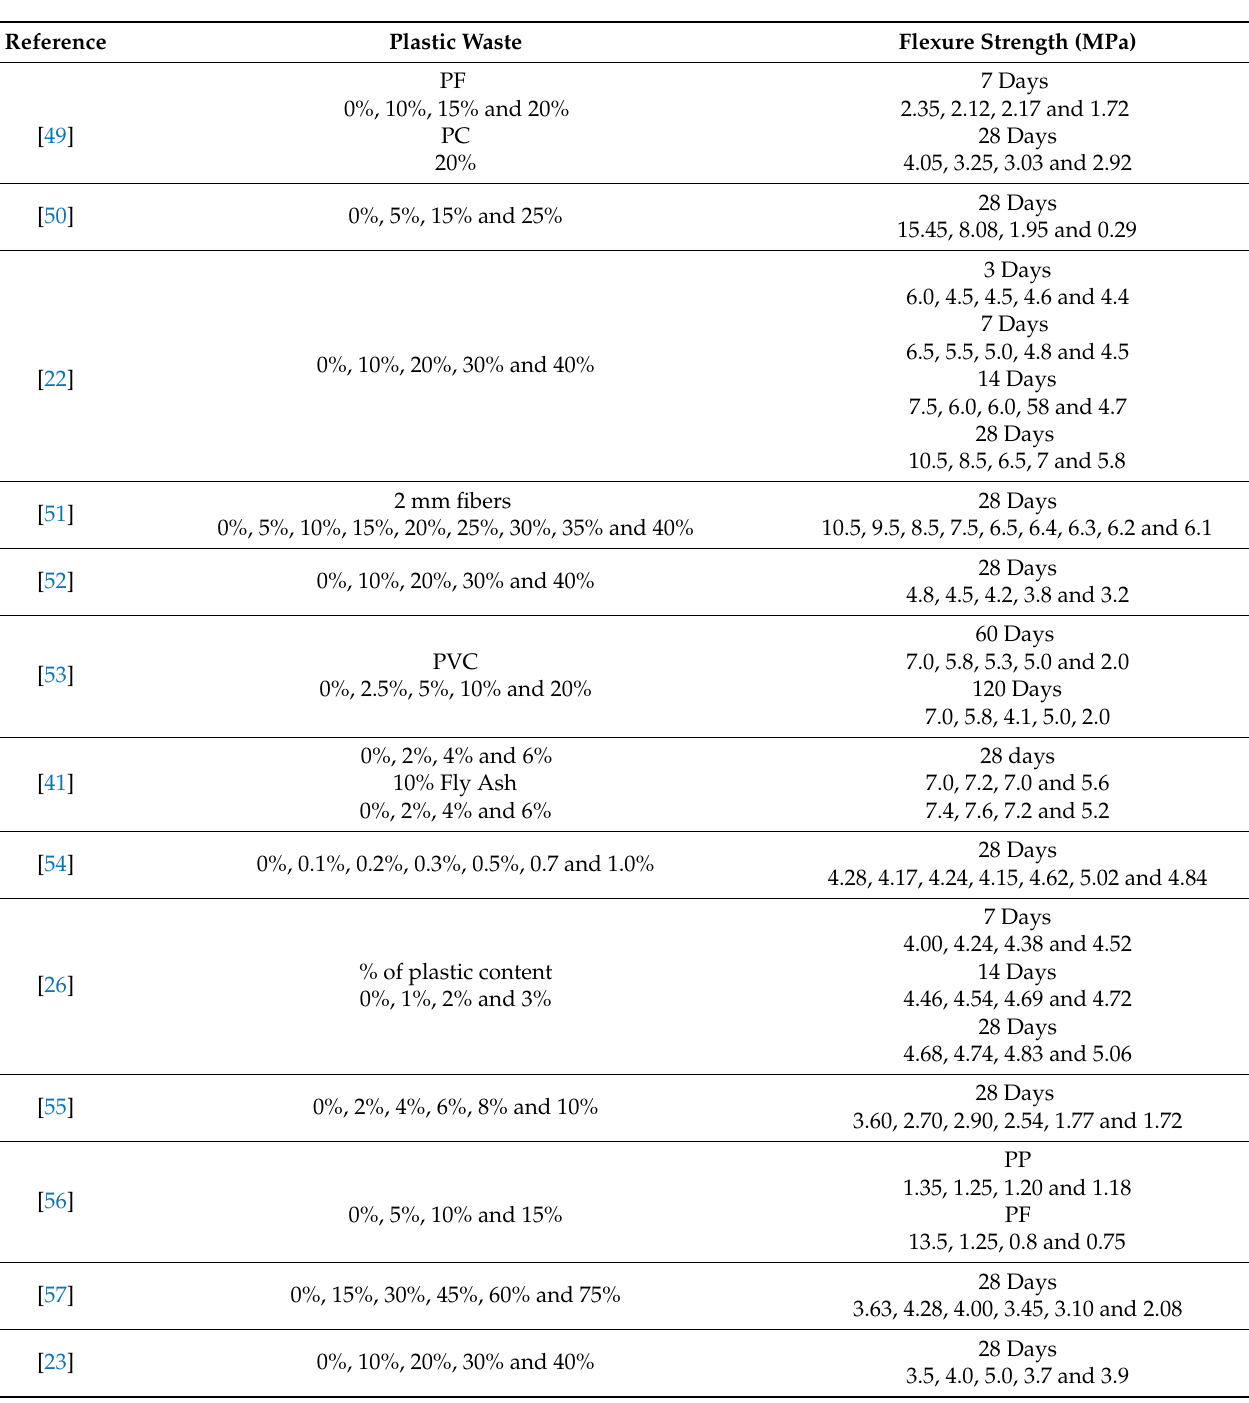
Table 4. Summary of Flexural Strength